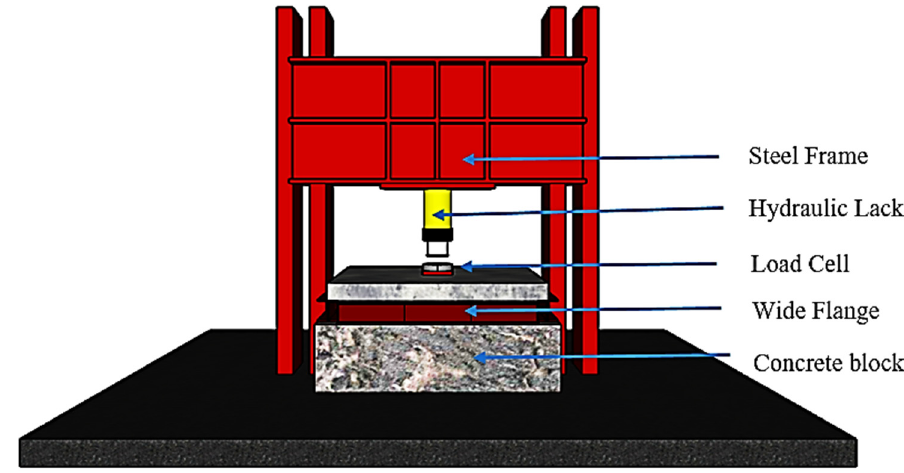
Figure 5. Load Setup.